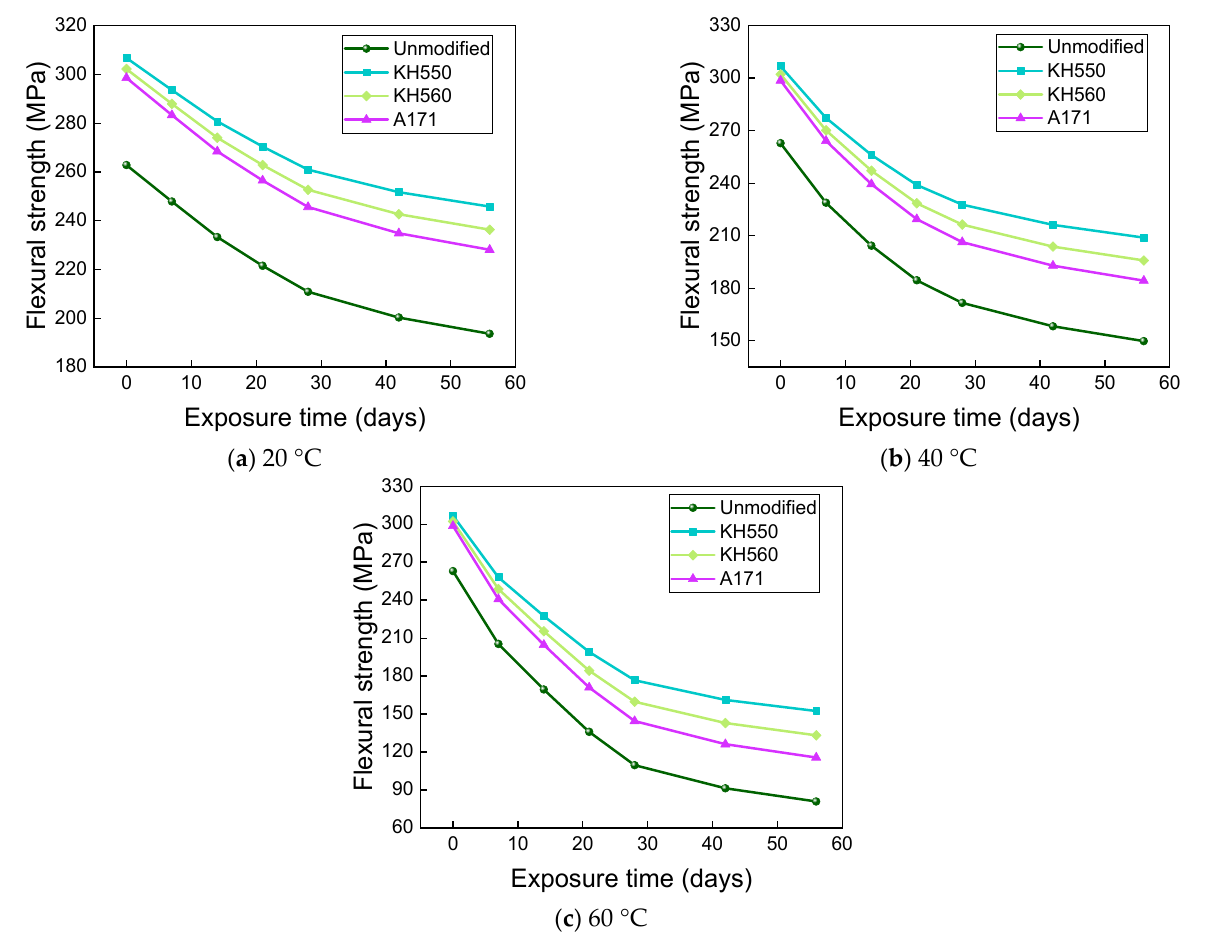
Figure 27. Flexural strength in a 10% NaOH alkaline environment.